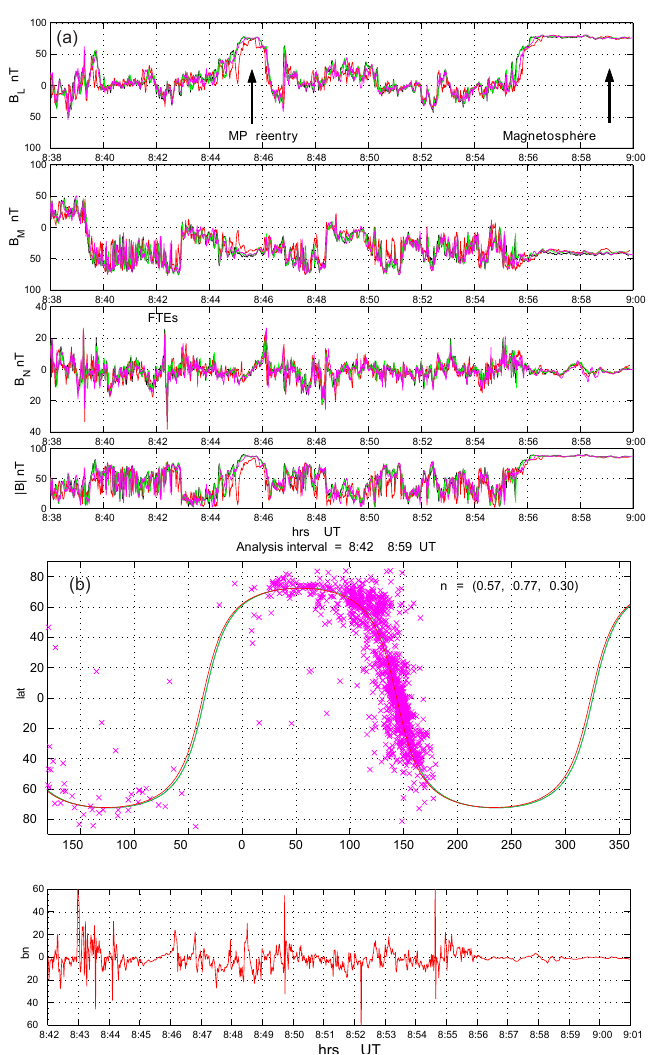
Fig. 4. (a) Interval of data in minimum variance coordinates around crossing 1, as in Table 1. MVA is performed for each spacecraft separately in order to express the data in LMN coordinates. The interval is chosen to show both the brief re-entry into the magnetosphere and two clear FTE signatures in the magnetosheath. The analysis is performed at high resolution (22.4Hz). (b) Result of the boundary analysis, as described in the text, where the interval plotted refers to the scatter plot. The MVA was performed across the MP at 08:56